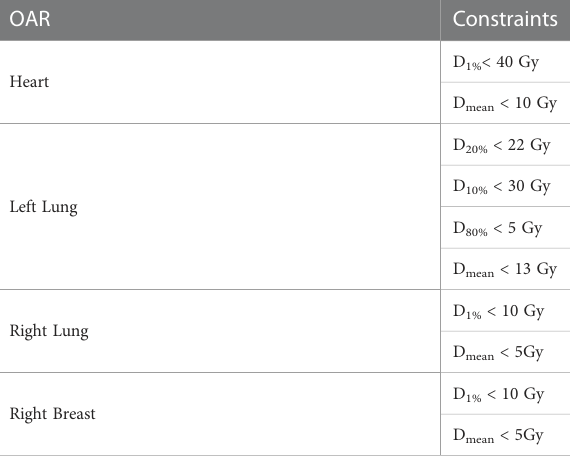
Table 1. Dose distributions were calculated with the analytical anisotropic algorithm (v15.5, Varian Medical Systems, Palo Alto, CA, USA) on a TrueBeam linear accelerator equipped with a Varian 120 multileaf collimator.